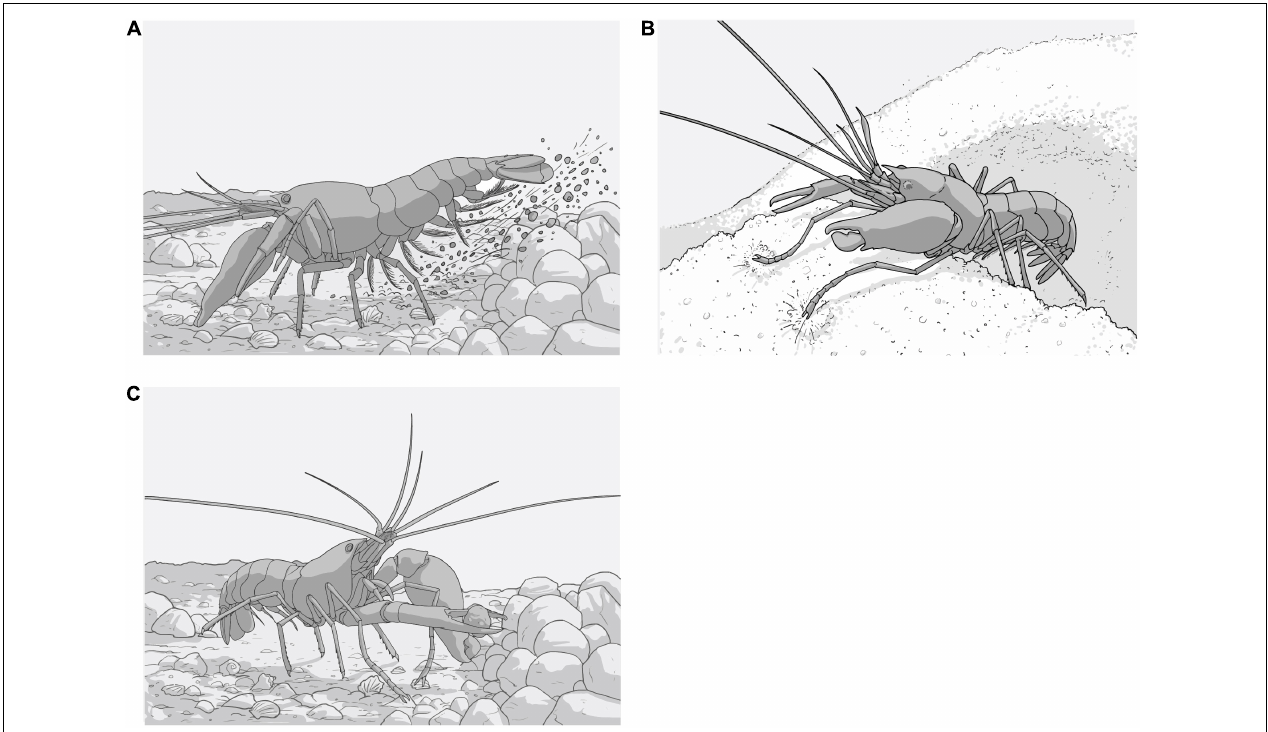
FIGURE 4 | Diagrams representing the body posture, movement and appendices used by Alpheus armatus complex when displaying three den cleaning behaviours during observations in experimental conditions. (A) Sweeping: shrimp used their pleopods remove the sand from under the abdomen toward the rear. (B) Tamping: shrimps tamped the surrounding sediment down firmly using the second pair of chelated pereiopods. (C) Dumping: shrimp used the first minor chela to lift larger sediment particles and move them away from the